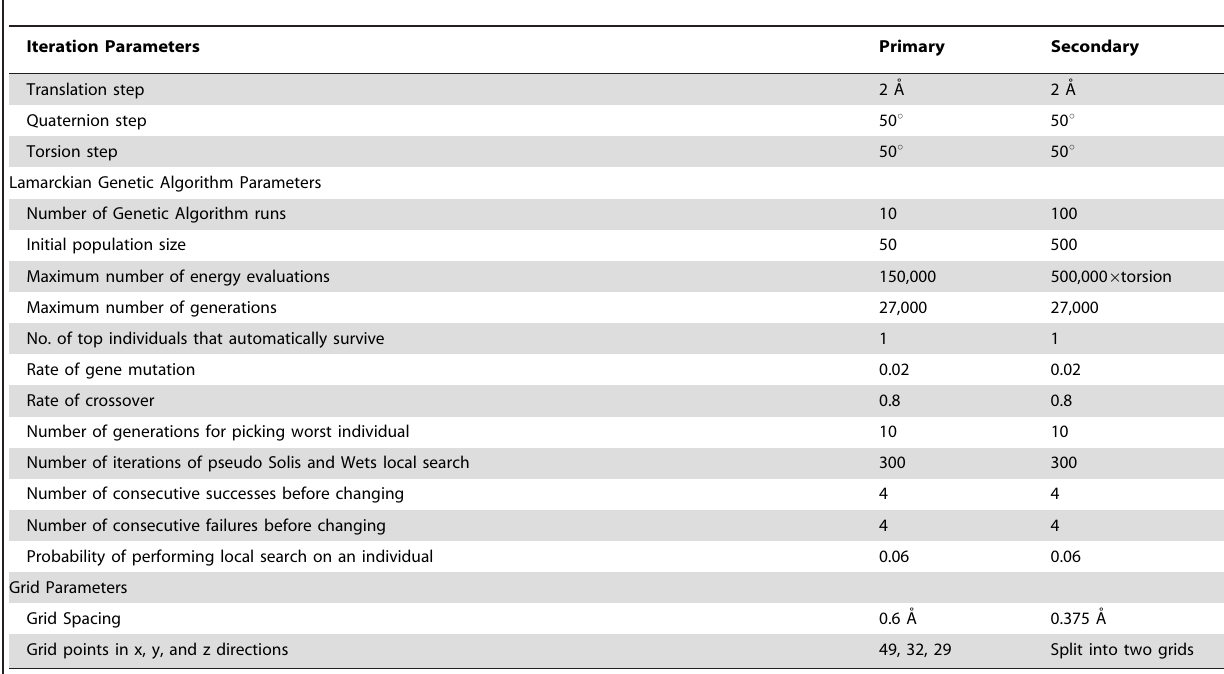
Table 2. Parameters used in the primary and secondary screening of the